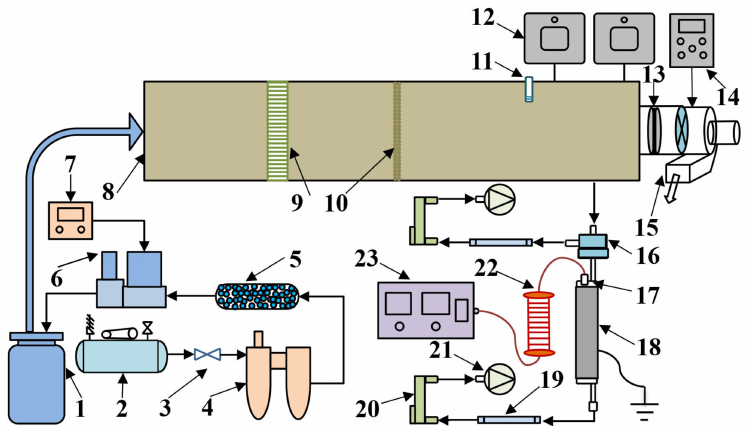
Figure 5. Schematic diagram of the experimental system. (1—Oil mist generator, 2—Air